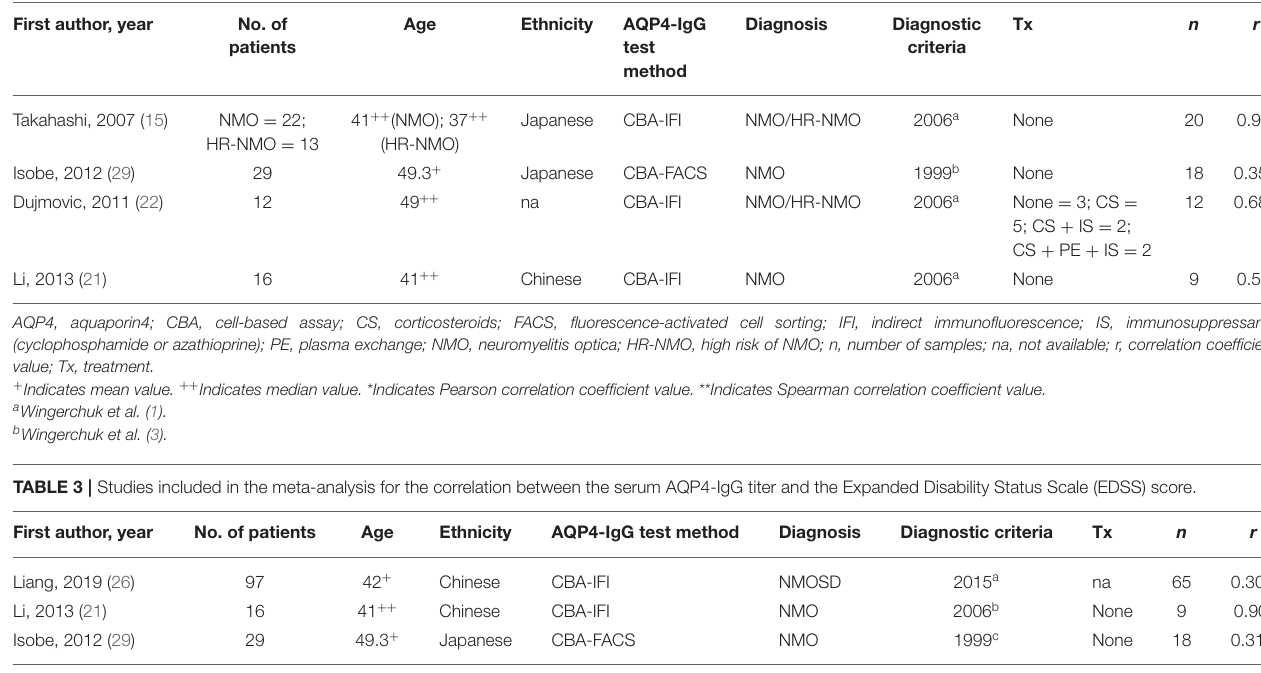
TABLE 2 | Studies included in the meta-analysis for the correlation between the serum AQP4-IgG titer and the number of involved spinal cord segments.